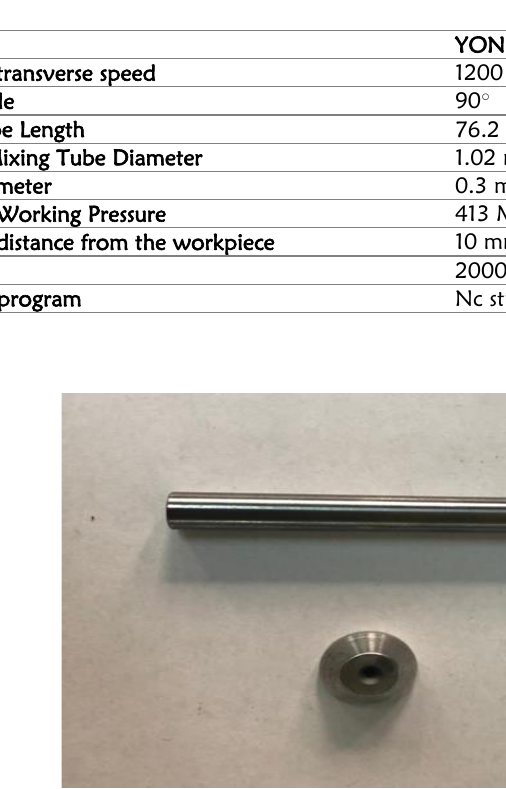
Figure 3: Orifice and mixing